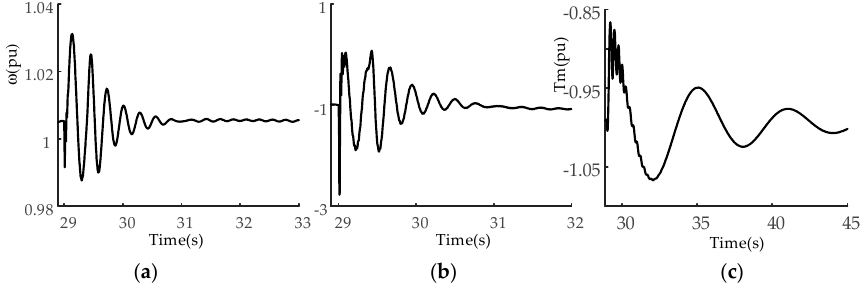
Figure 12. Impact of the three-phase ground fault in the Base case ( a ) Rotational speed ( b ) Electromagnetic torque ( c ) Mechanical torque.